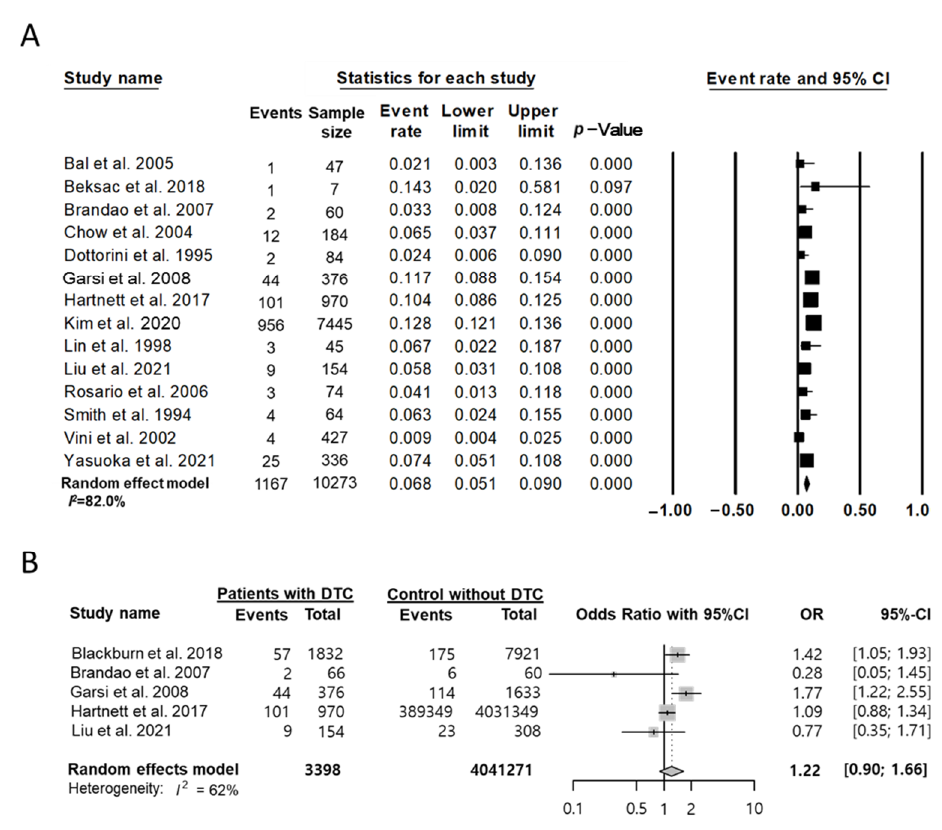
Figure 3. Effect of treatment of DTC on preterm labor. ( A ) Event rate among cases of pregnancy and ( B ) the OR between patients with DTC and controls without DTC. Studies referenced: [20,21,25–27,30–32,34–38,40,42].